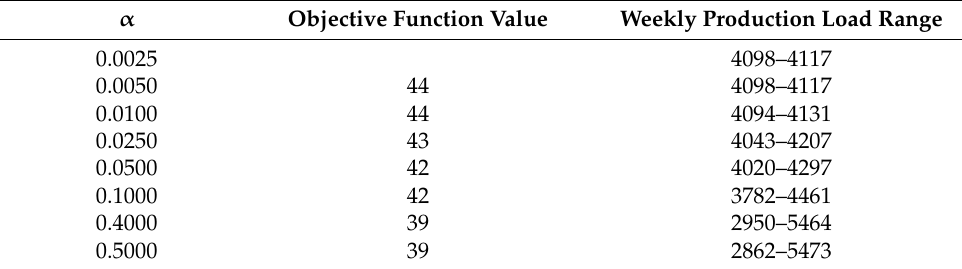
Table 9. Results of Case 4 at various values of α